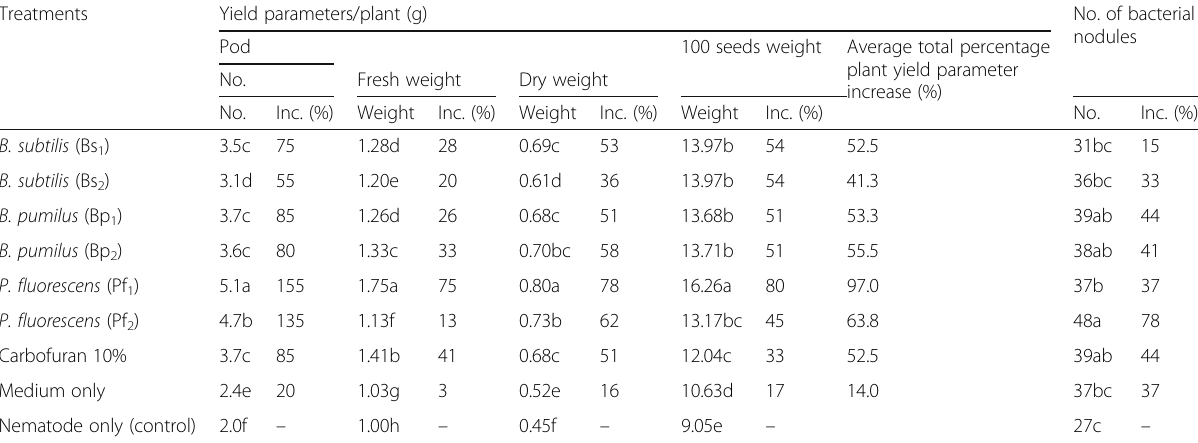
Table 3 Effects of Bacillus subtilis , B. pumilus , and Pseudomonas fluorescens isolates on yield parameters of cowpea grown under screen house conditions and infected with root knot nematode, Meloidogyne incognita Treatments Yield parameters/plant